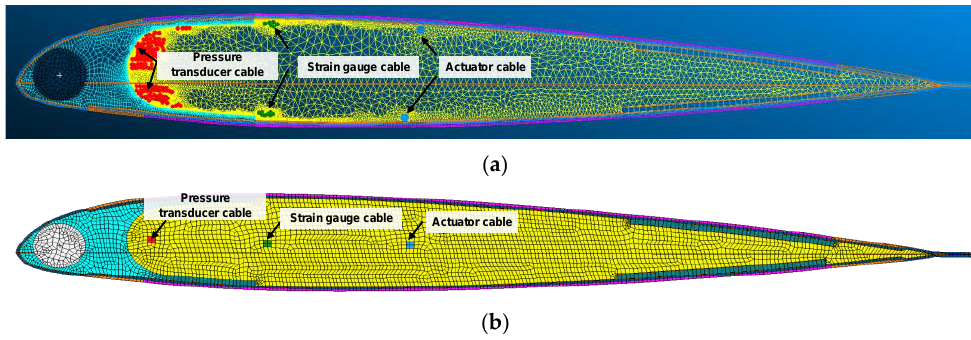
Figure 7. FE mesh of a blade airfoil section (U6) incorporating sensor cables. ( a ) Full FE mesh with individual cables. ( b ) Reduced FE mesh with lumped mass of cables.